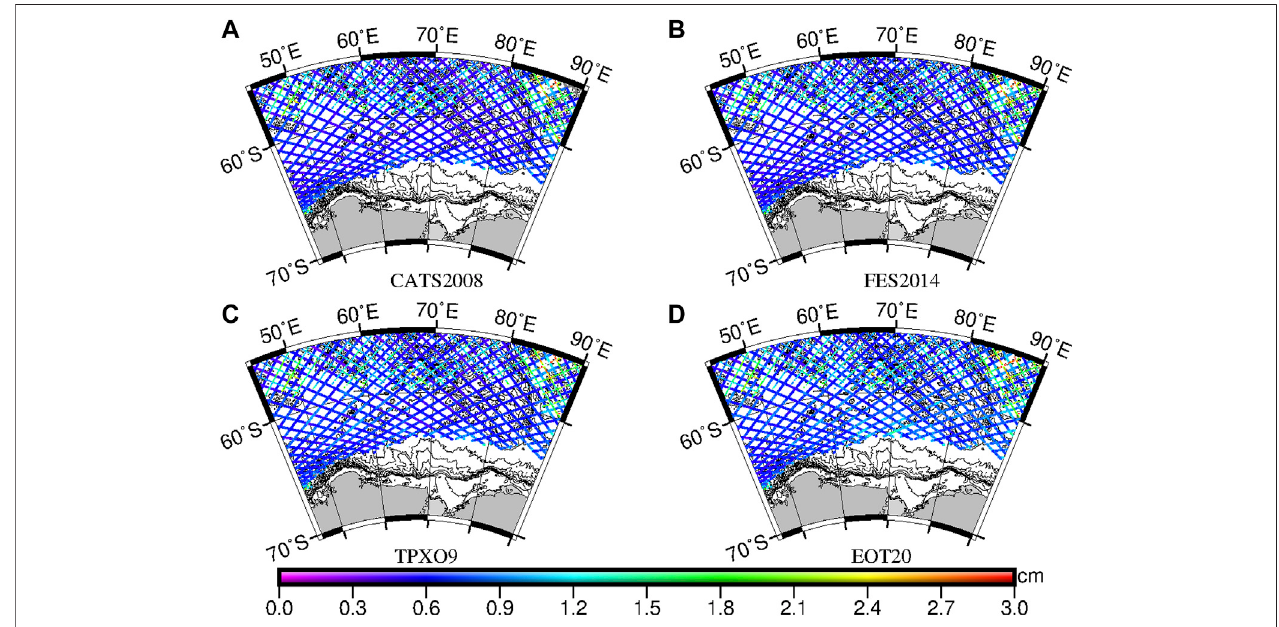
FIGURE 11 | RSS of each along-track point of (A) CATS2008, (B) FES2014, (C) TPXO9, and (D) EOT20 in the Kerguelen Islands, including original orbit (large points) and interleaved orbit (small points).